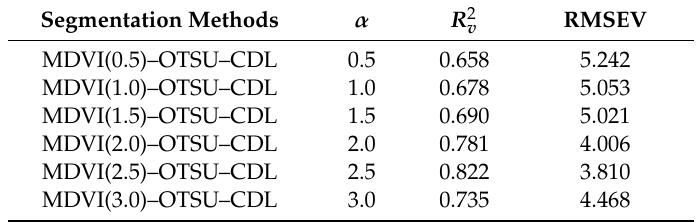
Table 5. Validation set results of PLS models of six segmentation methods.